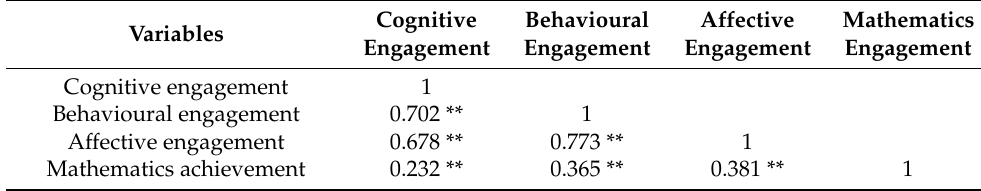
Table 6. Pearson correlation coefficient of relationship between cognitive engagement, behavioural engagement, affective engagement, and mathematical achievement.